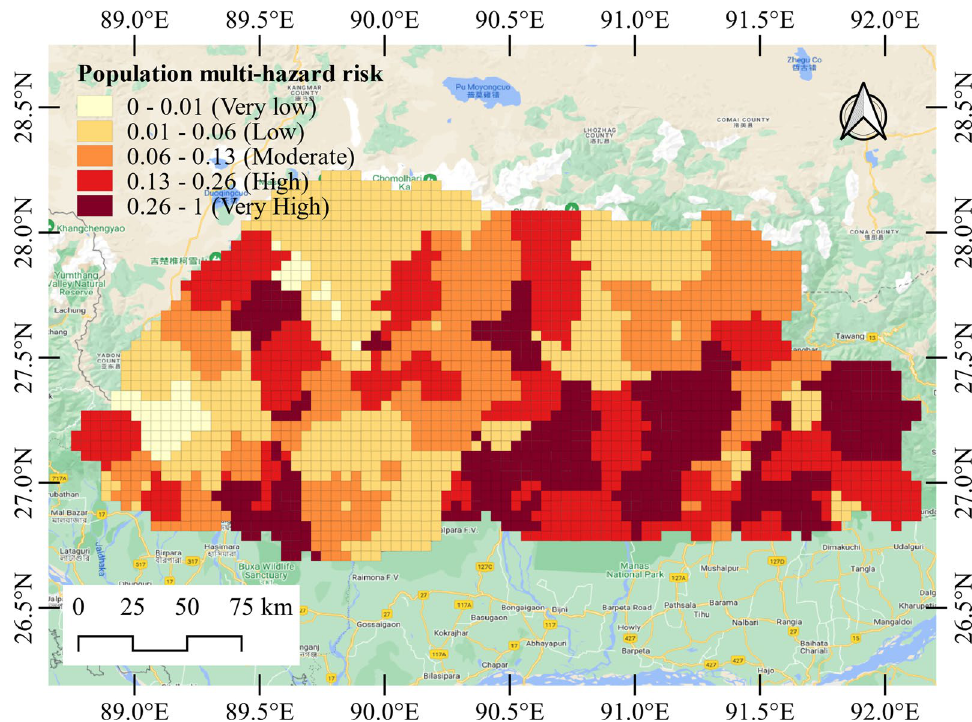
Fig. 10 Population risk map to multi-hazard for Bhutan at the local